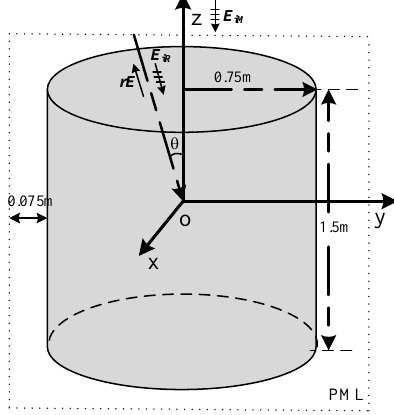
Figure 6. The model of the metal cylinder structure in the comparison of RCS and ARCS.